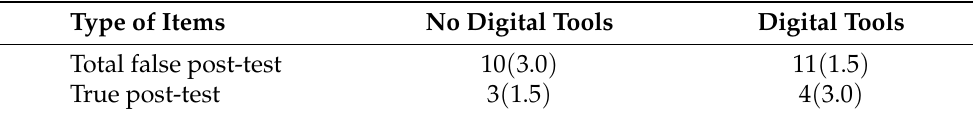
Table 3. Medians and median absolute deviation (in parentheses) for scores on total false post- test (maximum 14) and true post-test (maximum 7) for participants using/not using digital tools on post-test.